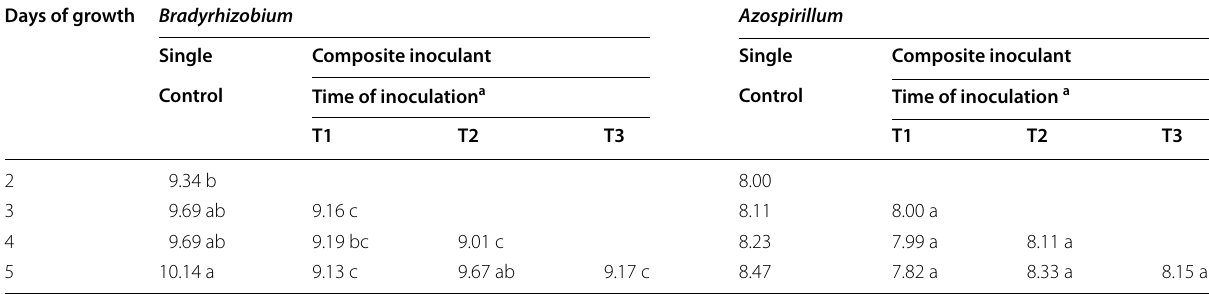
Table 4 Effect of different times of inoculation of Azospirillum on the growth (log of CFU) of Bradyrhizobium and Azospirillum co-cultivated in the same culture